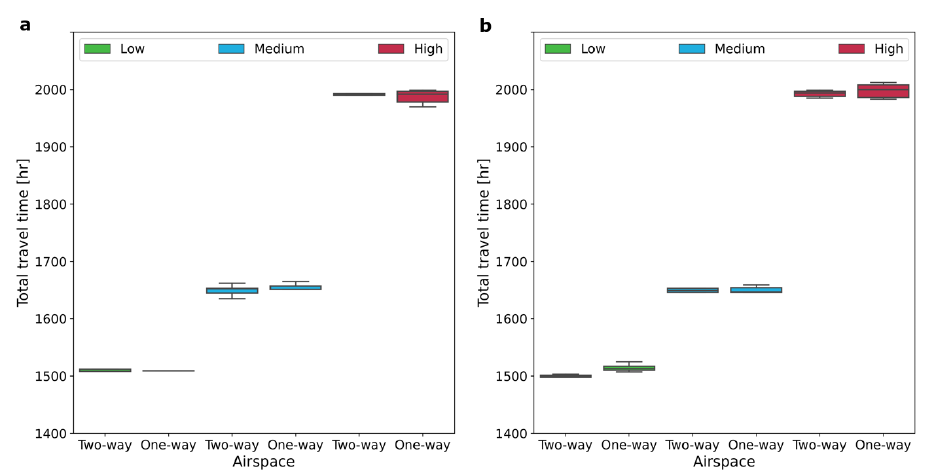
Figure 12. The total travel time for the two-way and one-way urban airspace concept for low, medium and high traffic demands. ( a ) Without conflict resolution. ( b ) With conflict